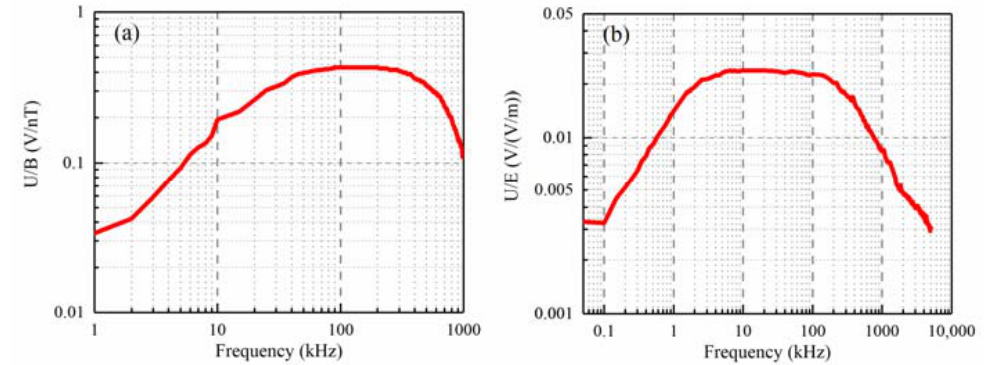
Figure 1. The frequency response curve of ( a ) magnetic field antennas and ( b ) fast electric field antennas. The lightning detection and location network was under stable operation during the summer of 2021. Figure 2 shows the sensor locations within the lightning location network in Fujian Province. Other stations were installed below an elevation of 250 m, except JXS (1667 m) and DH (1654 m) stations. In order to analyze the effect of number and configuration of participating stations on the quality of the lightning location outside the network, six cases from different directions were chosen. The red crosses mark the six cases whose position is estimated by using the ToA technique with the time corresponding to the peak field, using 10 stations’ (9 stations for case 2 and case 3) simultaneous waveforms data. The distances of the six cases to each station are about 220 km, 430 km, 400 km, 120 km, 240 km and 270 km on average,